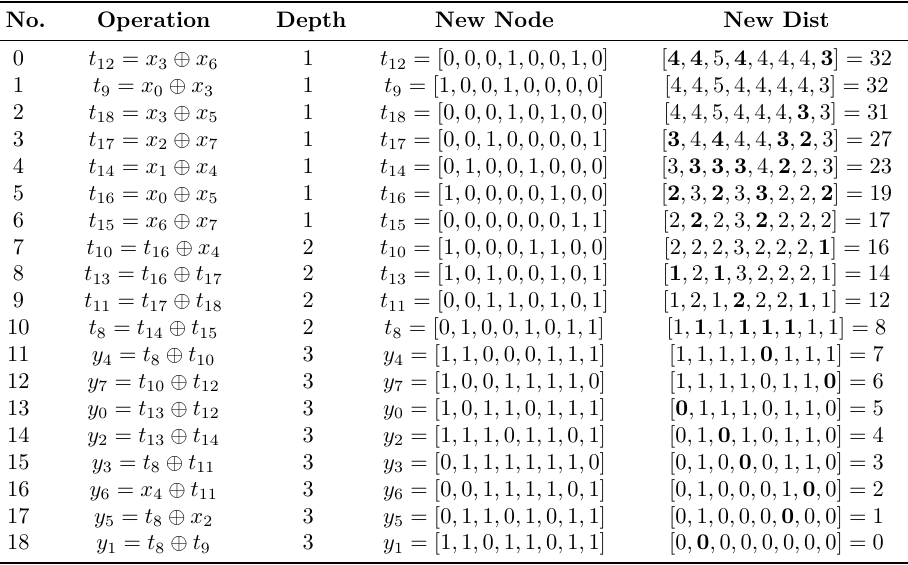
Table 6: The implementation of M C using our